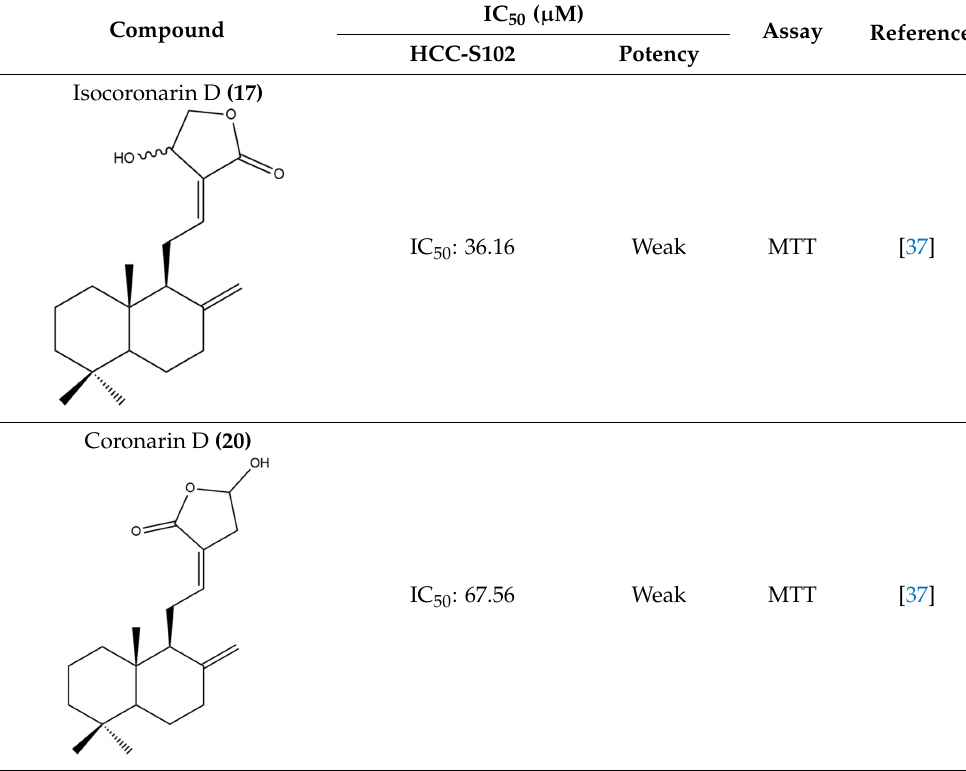
Table 12. Cytotoxic activities of labdane-type diterpenes from the Zingiberaceae against HCC-S102 liver cancer cell line.